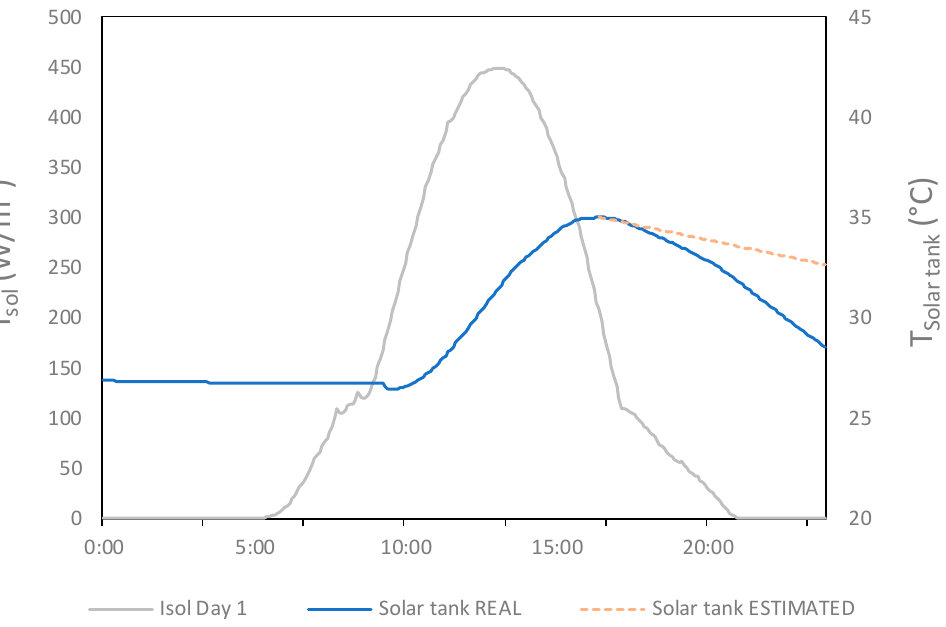
Figure 7. Temperature evolution in the solar storage tank during Day 1 (real and estimated cooling after maximum value).